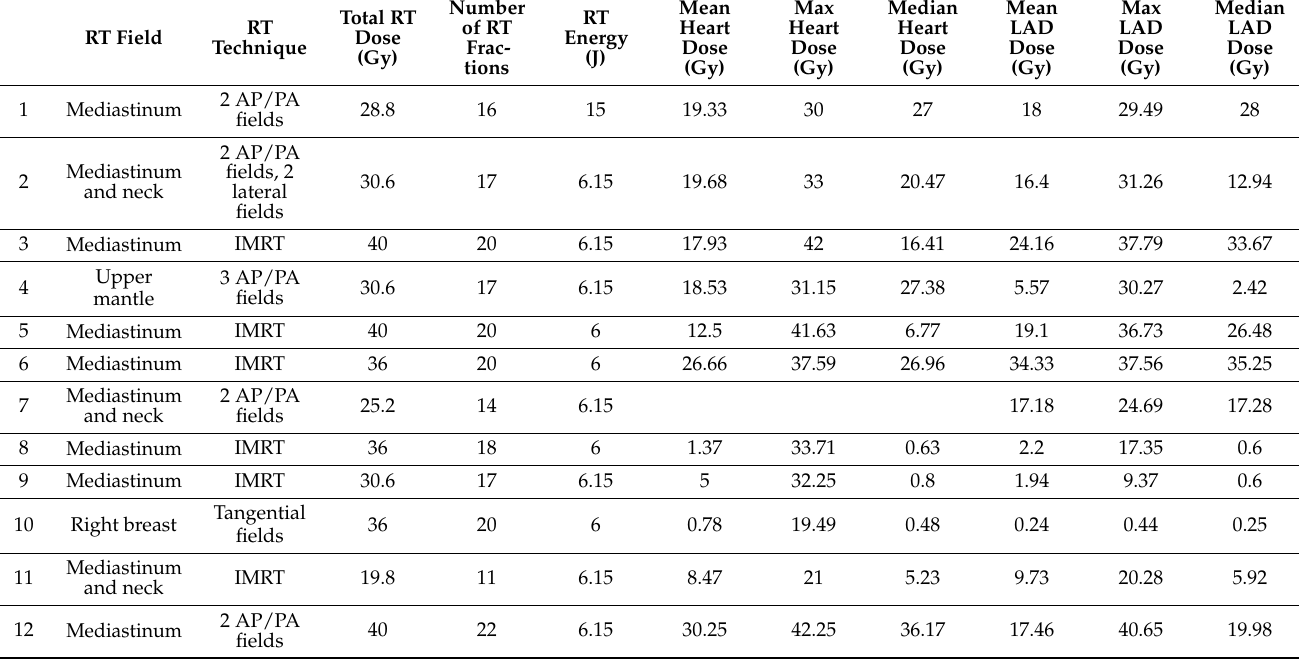
Table 2. Irradiation techniques and doses applied during radiotherapy